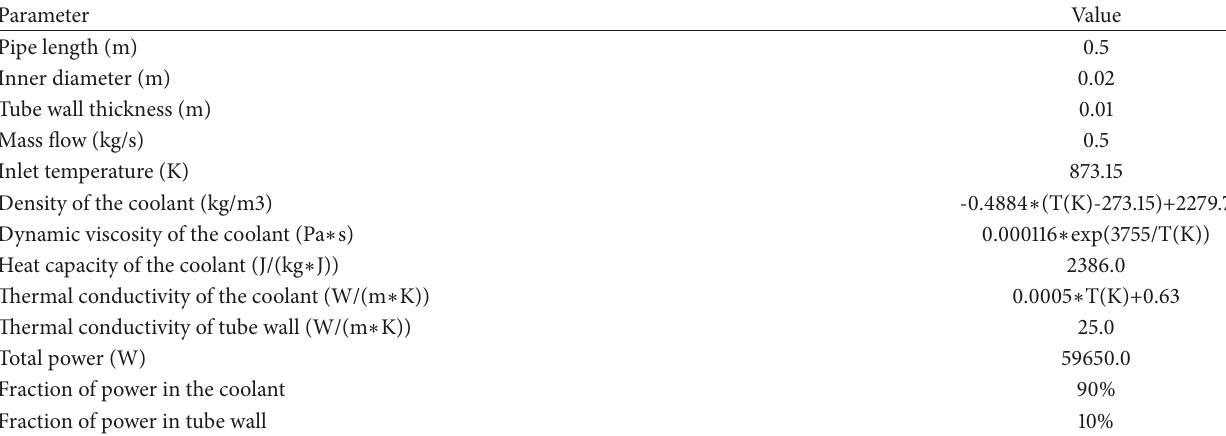
Table 1: Parameters used for the calculation